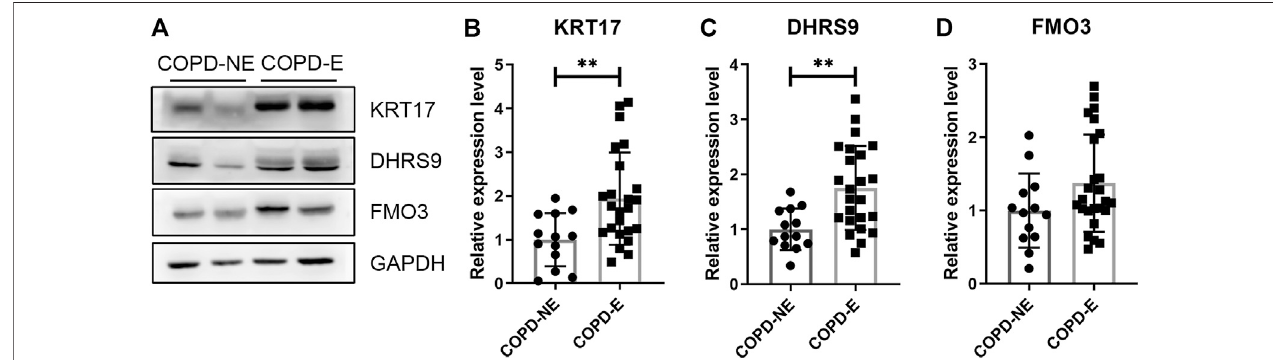
FIGURE6 | Type I cytoskeletal 17 (KRT17) and dehydrogenase/reductase SDR family member 9(DHRS9) expressionsare increased in thelung tissue samplesof patients with chronic obstructive pulmonary disease emphysematous phenotype (COPD-E). (A) Western blotting results of KRT17, DHRS9, and FMO3 expressions in the lung tissue samples of COPD non-emphysematous phenotype (COPD-NE) and COPD-E groups. (B-D) Quanti fi cation of KRT17 (COPD-NE, n (cid:2) 13; COPD-E, n (cid:2) 24), DHRS9 (COPD-NE, n (cid:2) 13; COPD-E, n (cid:2) 24), and FMO3 (COPD-NE, n (cid:2) 13; COPD-E, n (cid:2) 25) protein expressions. ** p <